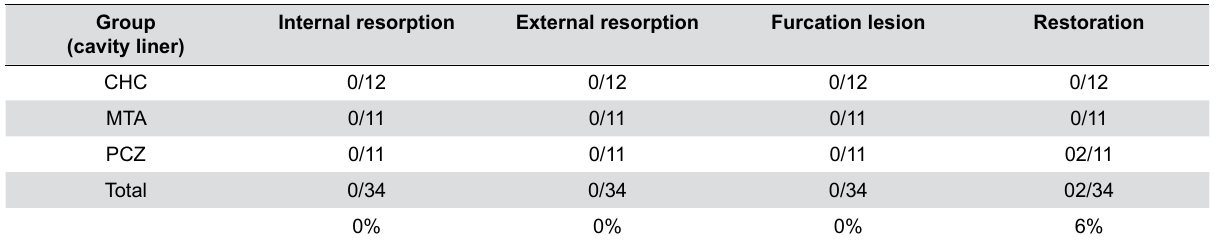
Table 2- Radiographic assessment of the use of different cavity liners in the selective caries removal from primary teeth, at 12-month